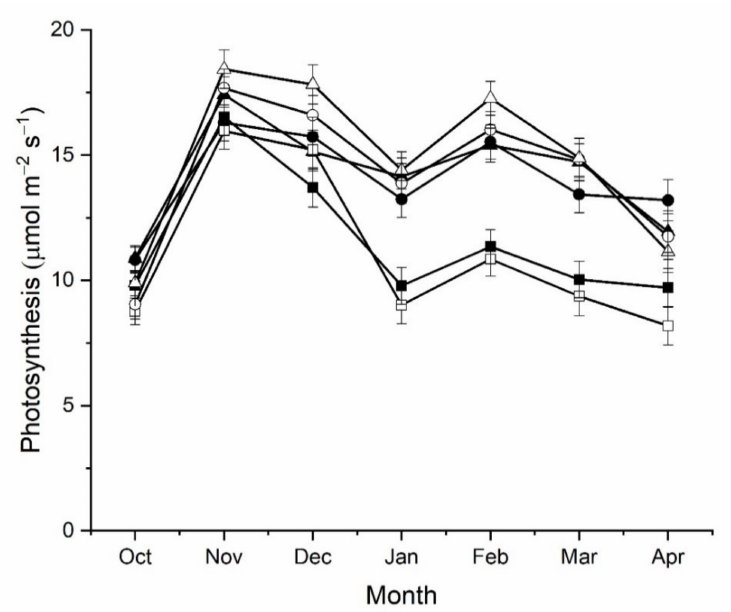
Figure 5. The effect of shoot type and rootstock on average net photosynthesis rates of leaves on Actinidia chinensis var. chinensis ‘Zes008’ shoots over a growing season. Measurements were taken from every second leaf sampled along individual shoots, to calculate an average value per shoot. Shoots were growing on vines with either A. chinensis var. deliciosa ‘Bruno’ rootstock (short (cid:4) , medium • or long (cid:78) shoots) or an A. macrosperma rootstock (short (cid:3) , medium Data are means of measurements from individual shoots ± SEM, n = 8.